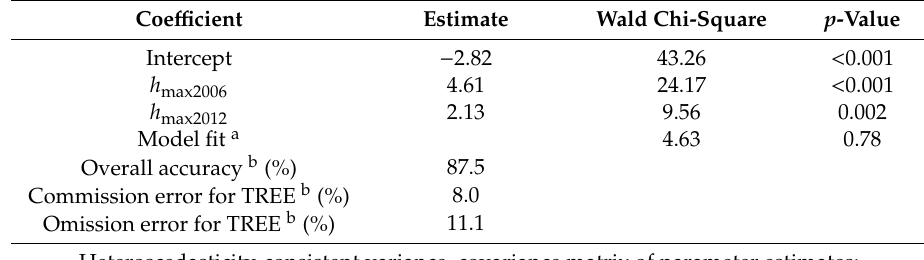
Table 3. Estimation results for the logistic regression model for probability of trees ≥ 1.10 m in height at both points in time, fitted according to Equation